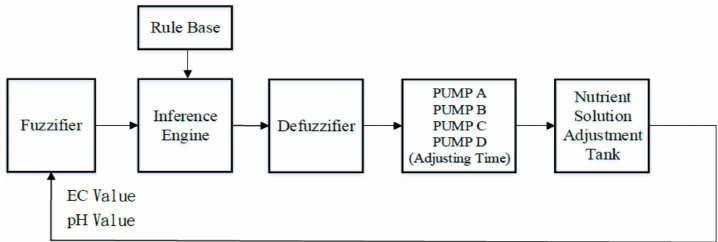
Figure 2. Hydroponic fuzzy controller